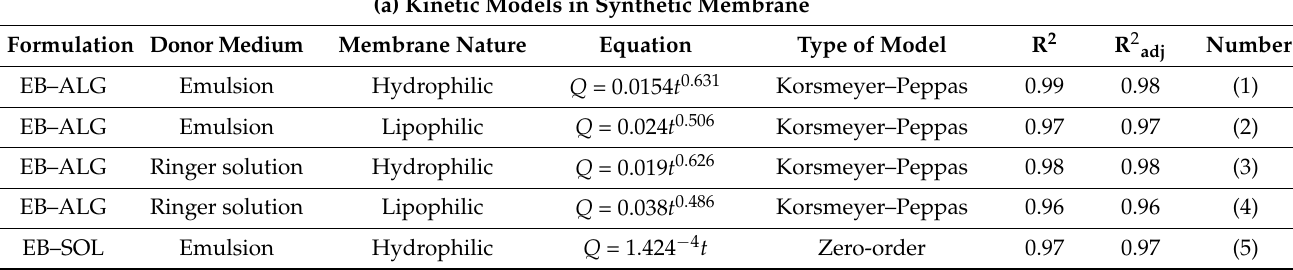
Table A2. Best-fit kinetic models for EB dissolution rate. (a) Kinetic Models in Synthetic